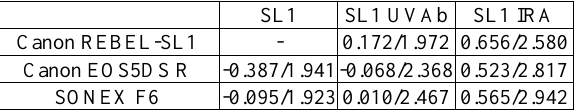
Table 13: geometric comparisons for OBJ 2 (mean/RMS distances in mm)